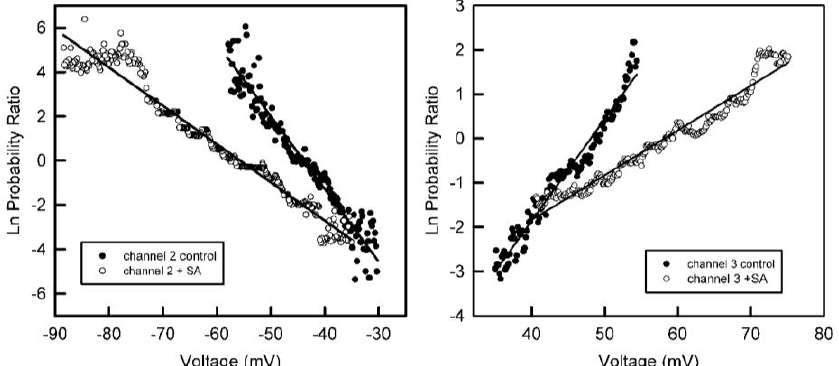
Figure 5. The data from Figure 4 were fitted to the Boltzmann 2-state distribution in order to obtain the voltage-gating parameters, n and V 0 . For subunit 2 that gates at negative potentials, the n value dropped from 8.4 to 4.8 and the V 0 increased from − 44 to − 55 mV. For subunit 3 that gates at positive potentials, the n value dropped from 5.9 to 2.5 and the V 0 increased from 46 to 70 mV after anhydride modification.